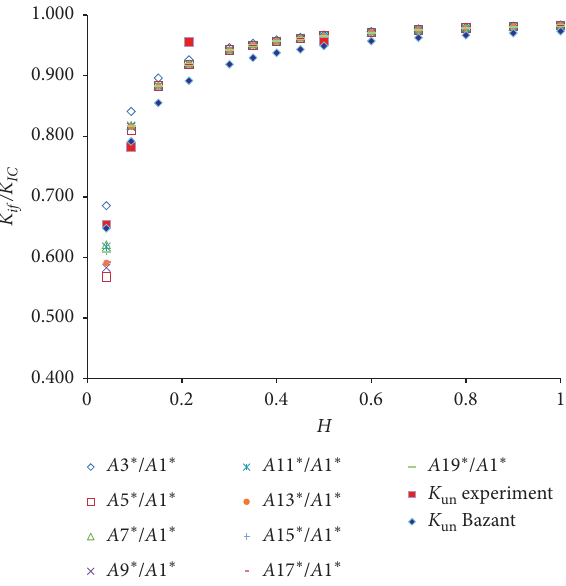
K ) versus height H of if / Ic